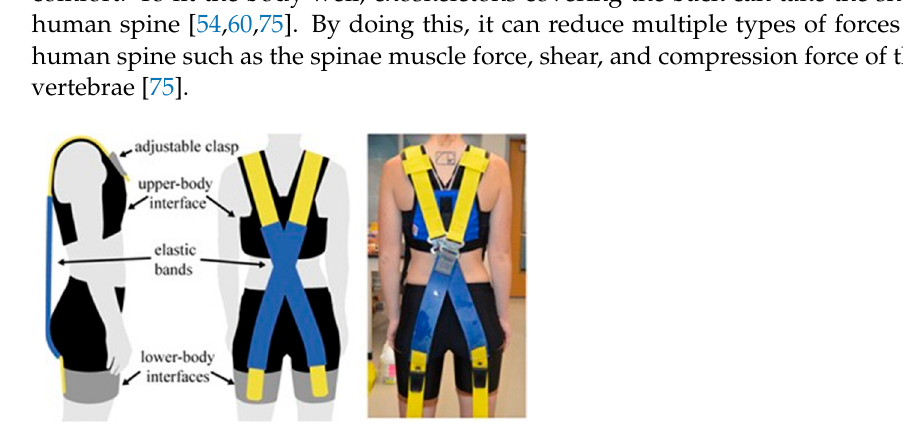
Figure 4. Bio-mechanically-assistive garment prototype [57]. Reprinted with permission from IEEE.